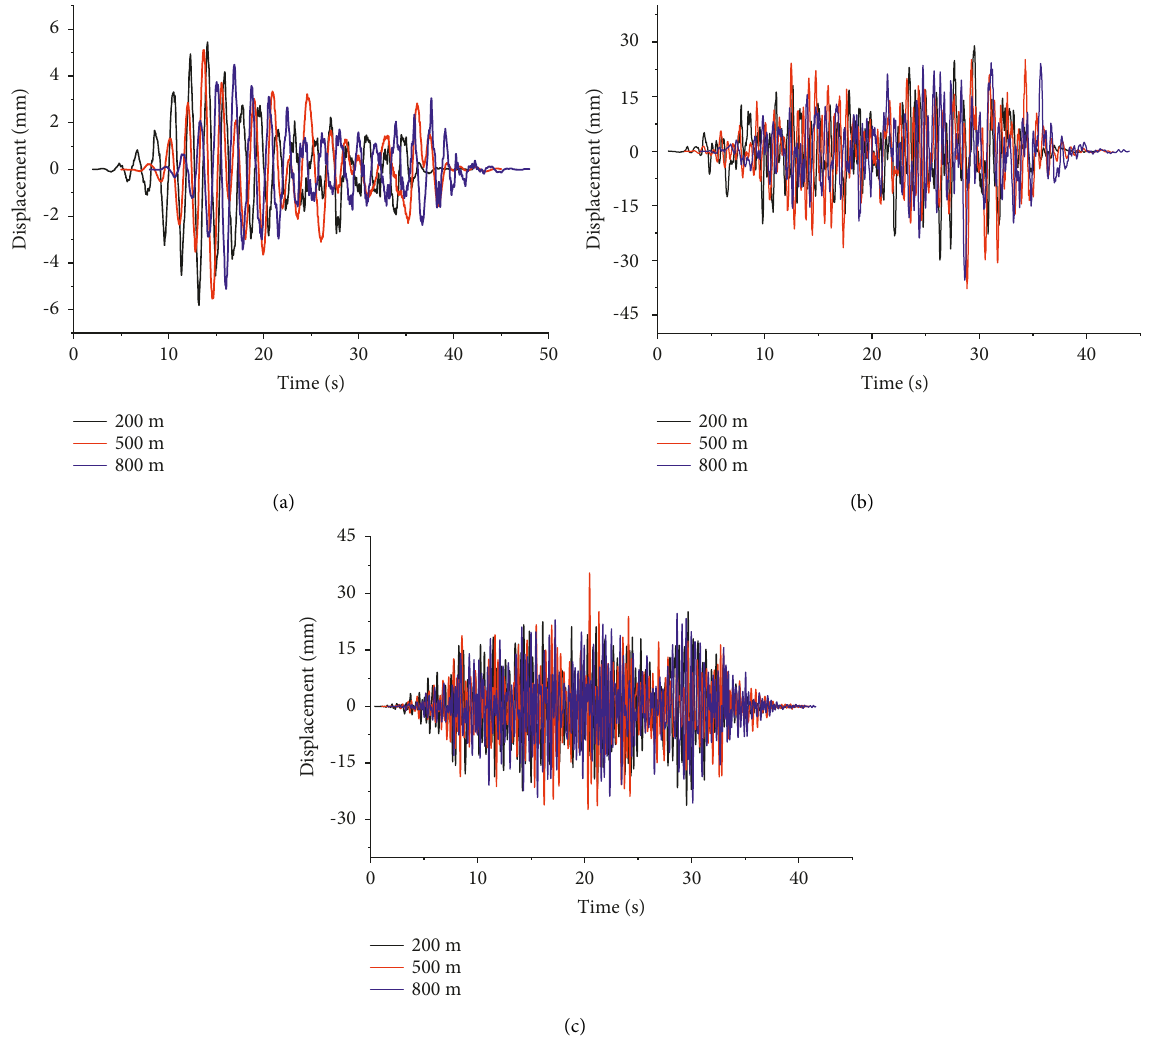
Figure 10: Time course curve of transverse vibration displacement of pipes at different positions. (a) Wave speed v � 100m/s (normal). (b) Wave speed v � 200m/s (vacant). (c) Wave speed v � 500m/s (polymer grouting